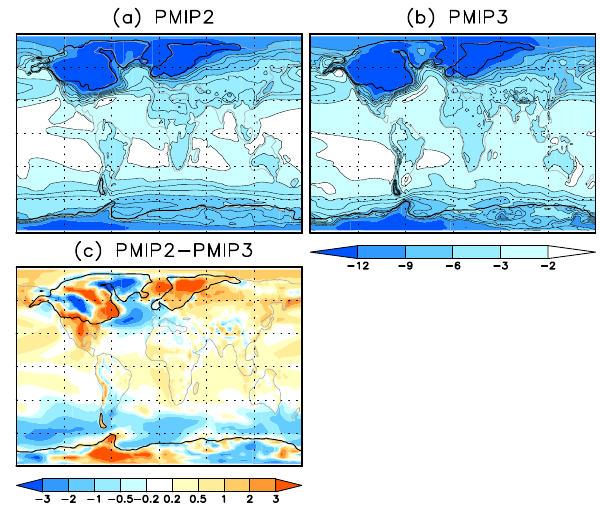
Figure 7. Differences in mean annual temperature ( ◦ C) caused by using different ice-sheet configurations from the CMIP5/PMIP3 composite ice sheet in simulations made with the MIROC slab ocean model. The individual ice-sheet configurations are the (a) PMIP2, (b) ICE-6G v.2, (c) GLAC-1a, and (d) ANU ice sheets, where each is referenced to the CMIP5/PMIP3 composite ice sheet. The land mask ( > 50% land) is shown in grey; the ice margin ( > 50% ice) is shown in black in all four plots.